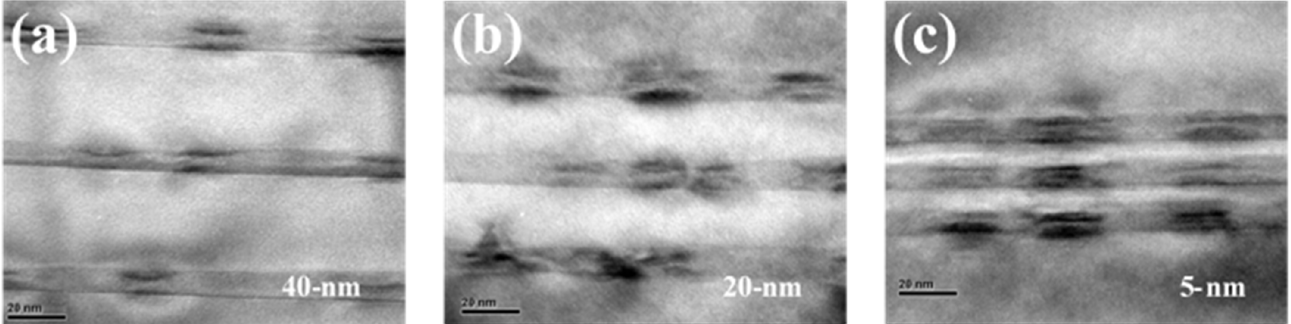
Figure 2. TEM cross-section BF images of the triple-layer In 0.75 Ga 0.25 As QDs with ( a ) d = 40 nm, ( b ) d = 20 nm, and ( c ) d = 5 nm, respectively.